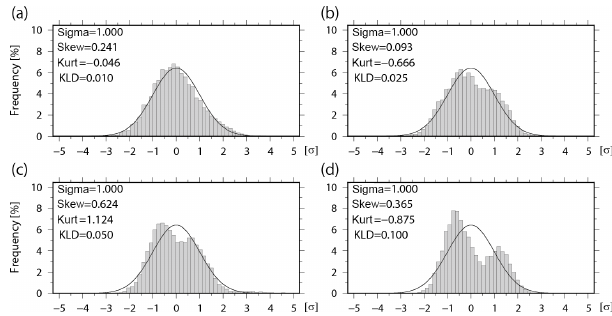
Figure 1. Ensemble-based histograms with 10240 ensemble mem- bers when the Kullback–Leibler (KL) divergence D KL = (a) 0.010, (b) 0.025, (c) 0.050, and (d) 0.100. Solid lines indicate fitted Gaus- sian functions. Skewness (Skew) and kurtosis (Kurt) are also shown in the figure.